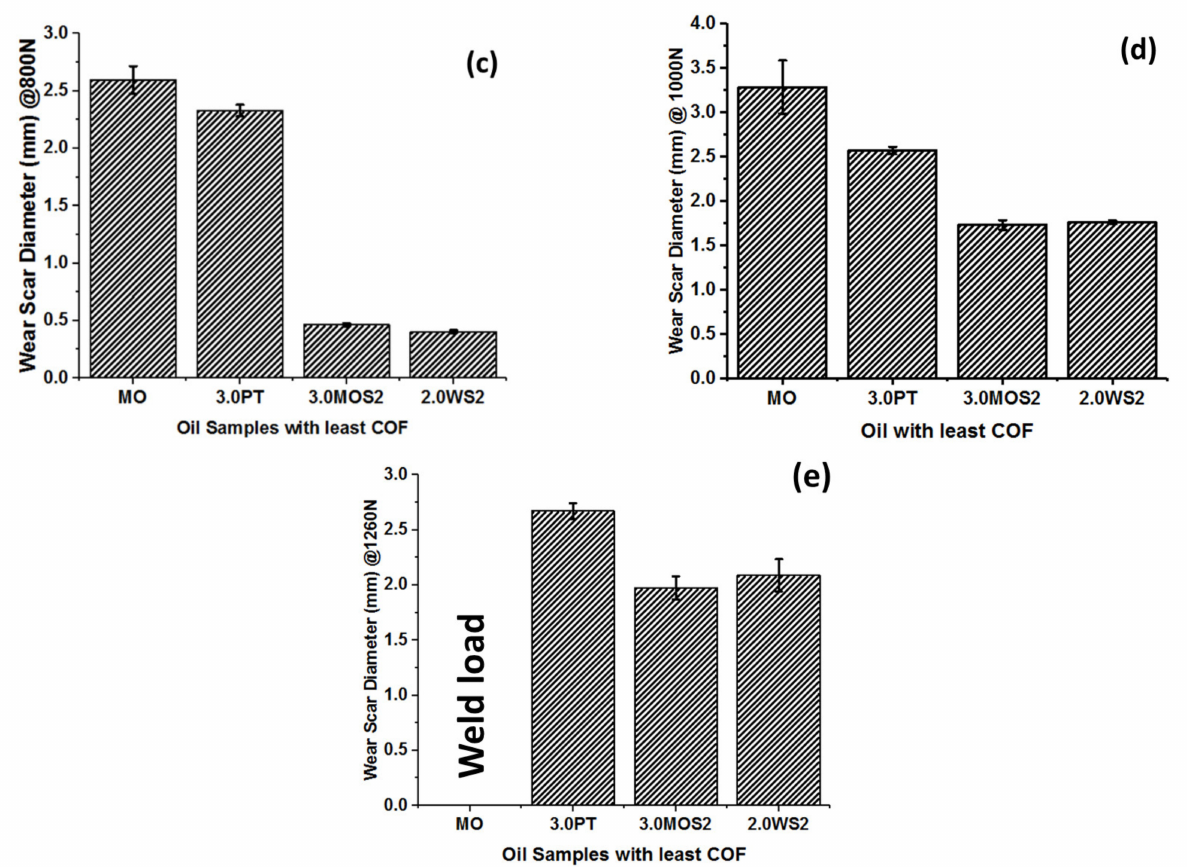
Figure 5. Wear scar diameters of the lubricant samples during extreme pressure tests at various loads of ( a ) 500 N, ( b ) 630 N, ( c ) 800 N, ( d ) 1000 N and ( e ) 1260 N.